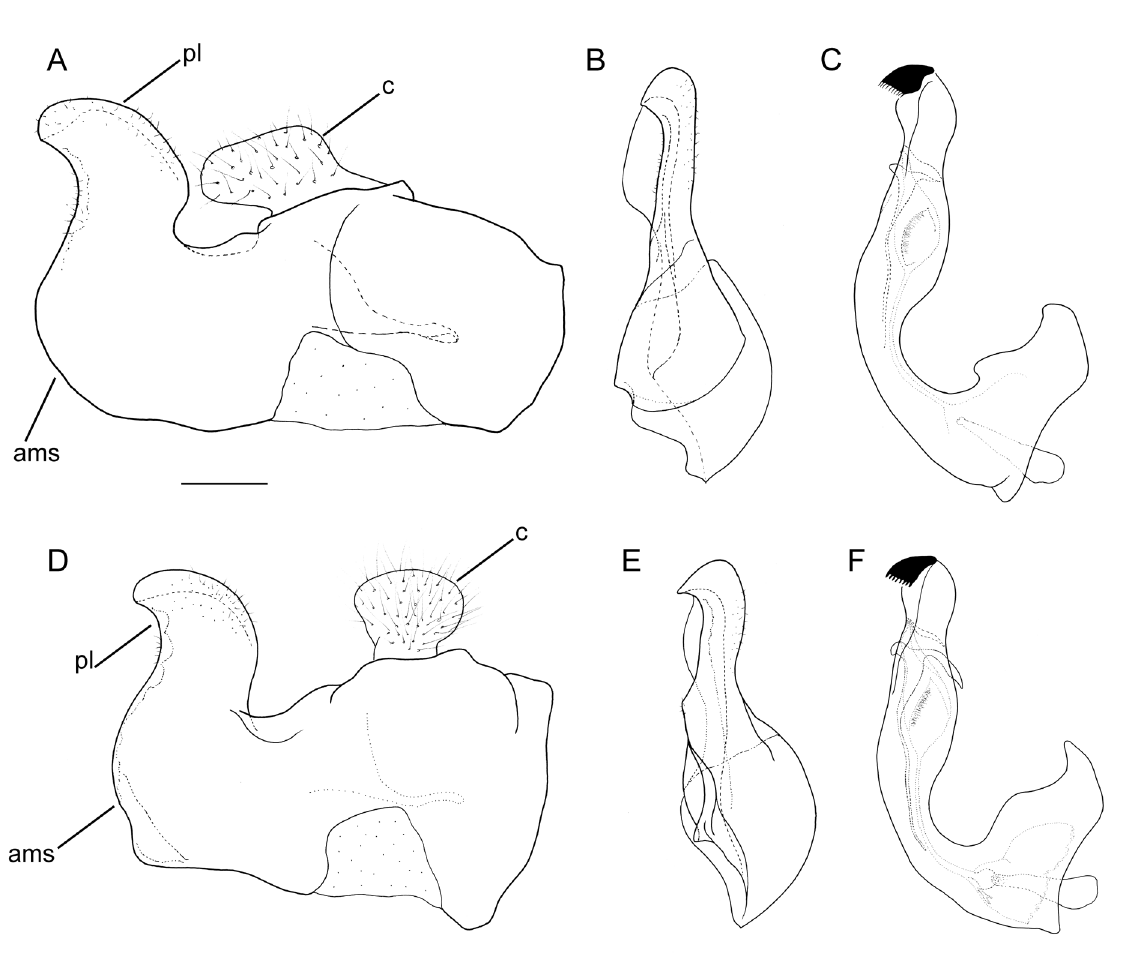
Fig. 17. Merodon lotus Vujić & Radenković sp. nov., male genitalia. Paratypes. A–C . Specimen FSUNS (FSUNS ID ZA6_066). D–F . Specimen FSUNS (FSUNS ID ZA6_060). A, D . Epandrium, lateral view. B, E . Epandrium, ventral view. C, F . Hypandrium, lateral view. Abbreviations: ams = anterior margin of surstyle; c = cercus; pl = posterior lobe of surstyle. Scale bar = 0.25